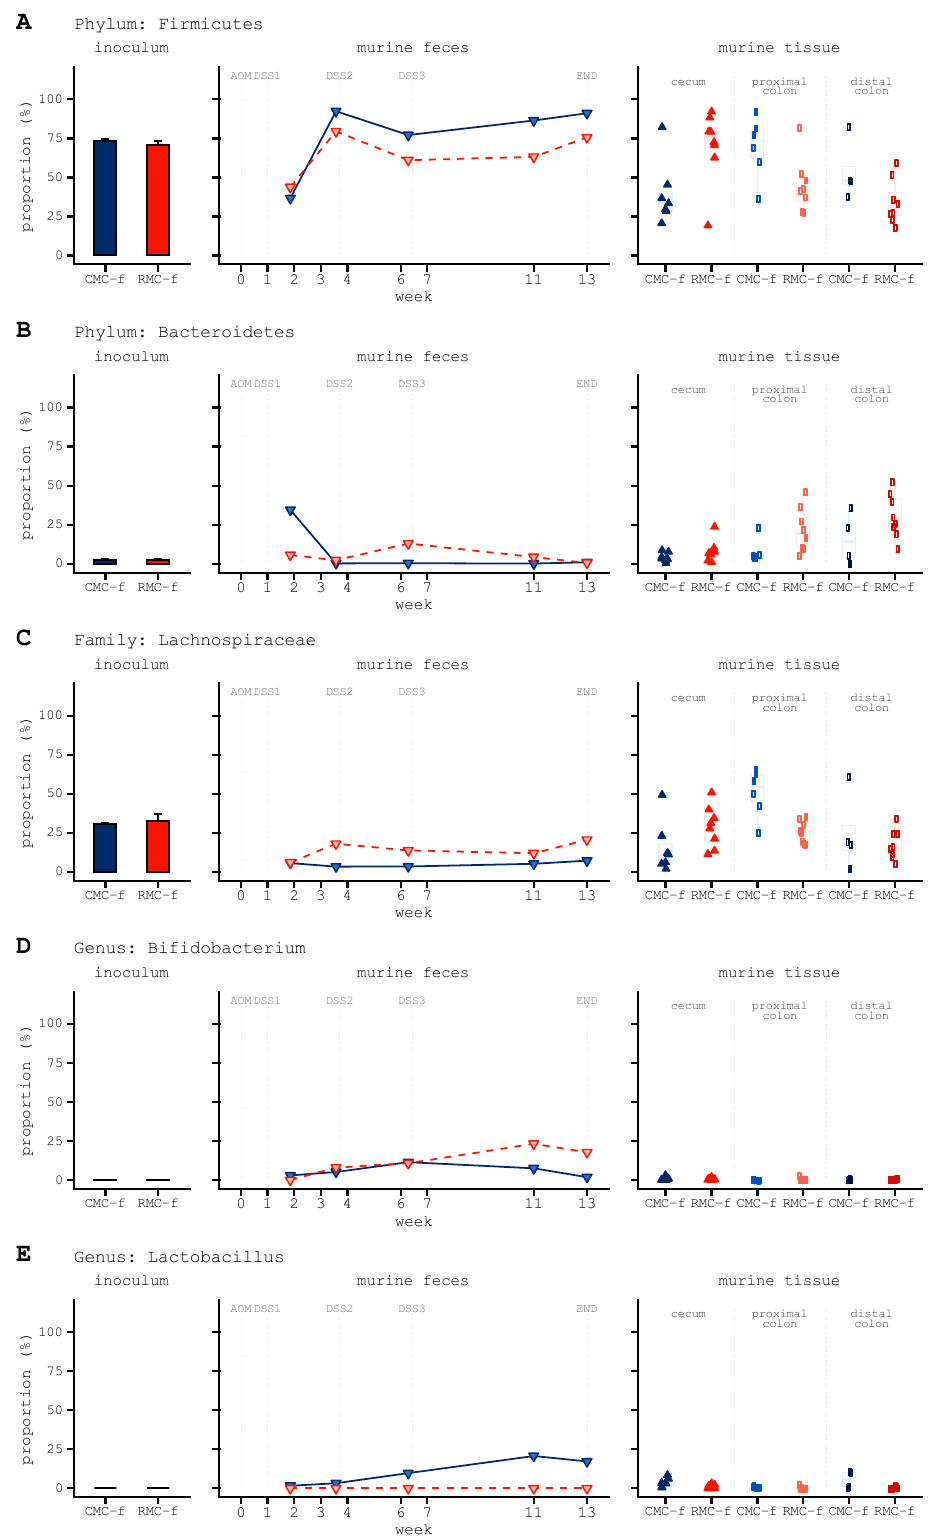
Figure 3. Taxonomic composition (proportions) of human female donor stool inoculums into murine feces, cecum, and colon. ( A ) Firmicutes ( B ) Bacteroidetes ( C ) Lachnospiraceae. ( D ) Bifidobacterium ( E ) Lactobacillus ( A – E ) the y-axis is identical across plots within a given panel and is set at 100% for all panels depicted. Taxonomy was collapsed at the phylum ( A , B ) family ( C ) or genus- ( D , E ) levels to combine proportions for identical assignments prior to visualization. Taxonomy was assigned using the SILVA 132 marker gene database.